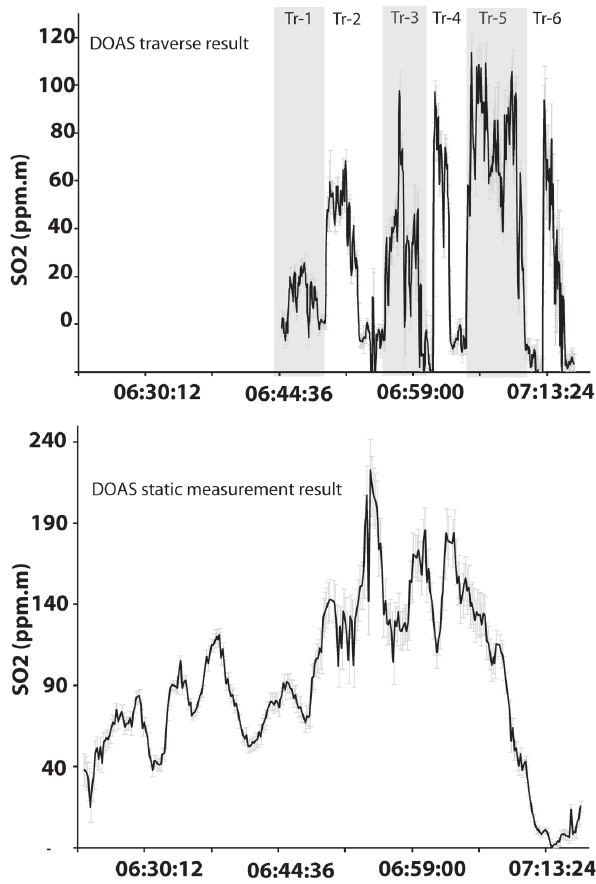
Fig. 4. Plots of traverse (above) and static (below) measurement results obtained on Papandayan. Time axes were aligned highlight- ing the increase of SO 2 column amounts in both static and traverse measurements.